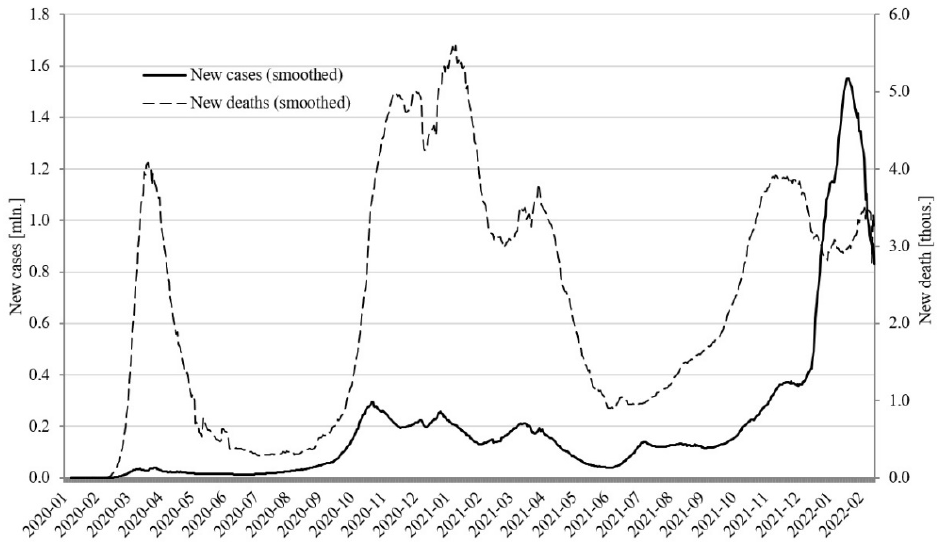
Figure 1. COVID-19 pandemic statistics in Europe. Source: Own study based on [39].